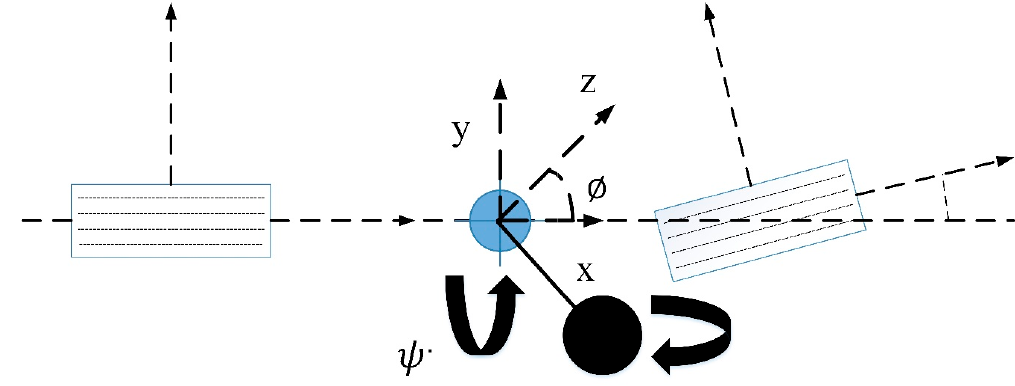
Figure 2. Track Vehicle Model .